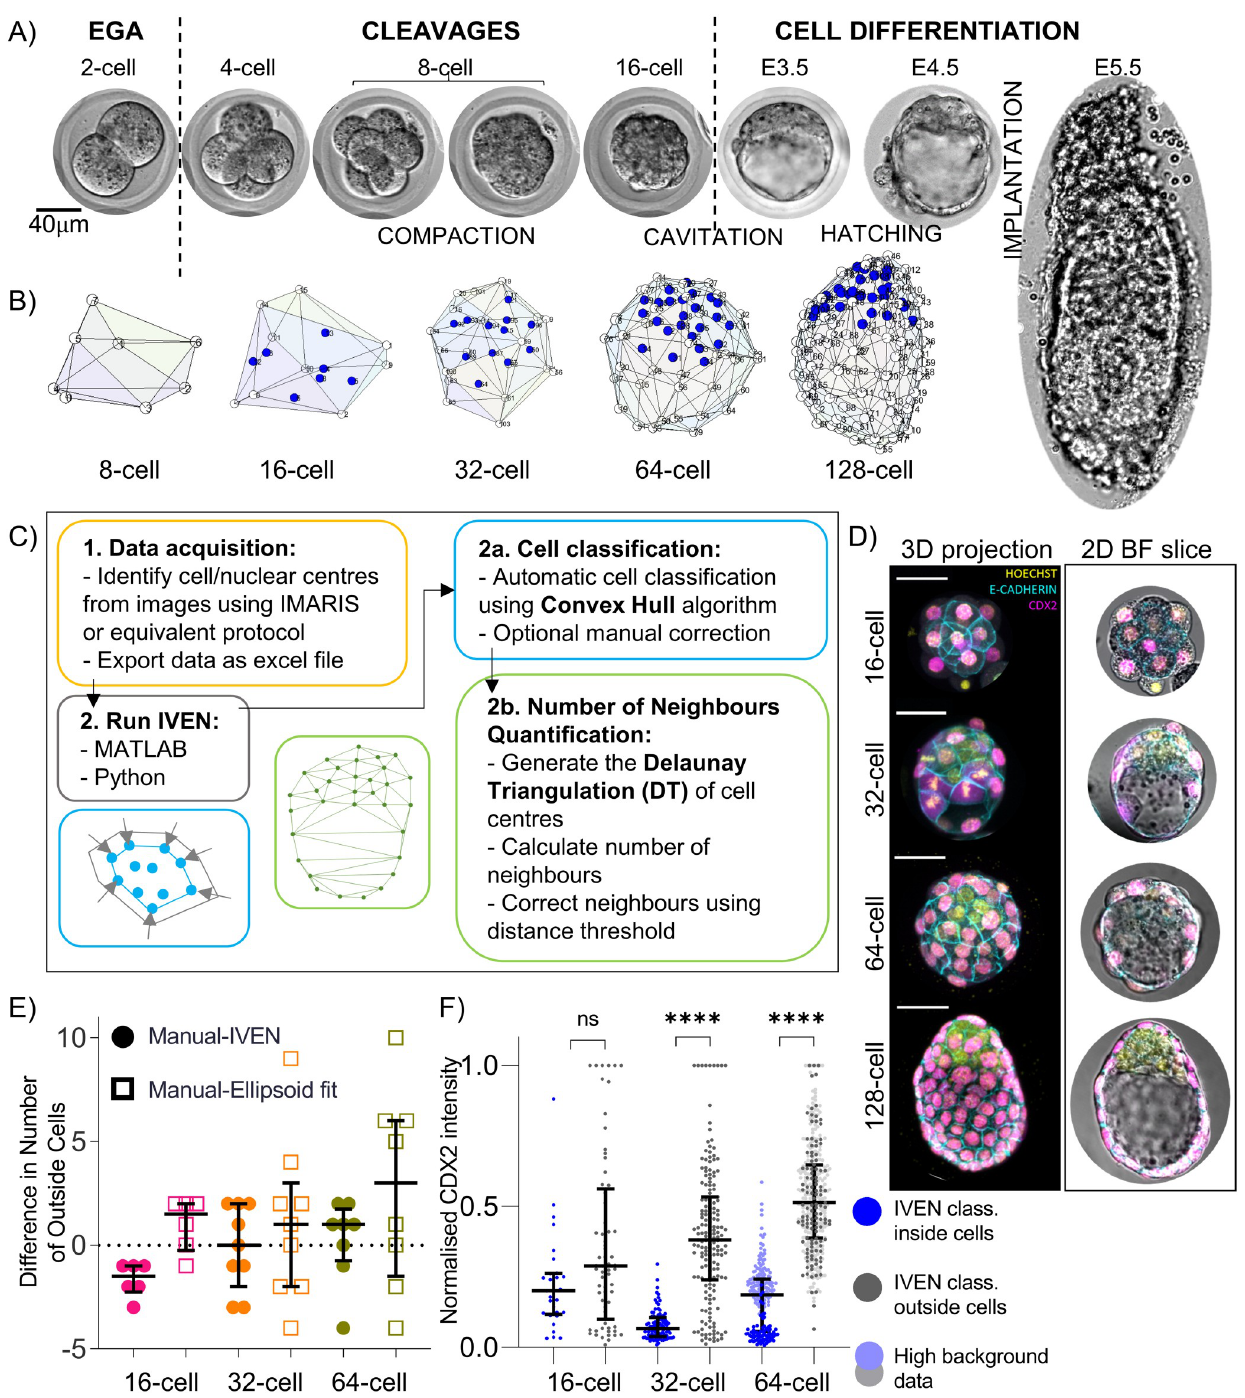
Fig 1. IVEN development and implementation in preimplantation stages of the murine embryo. (A) Brightfield images of the preimplantation and peri- implantation periods of the murine embryo. Scale bar, 40 μ m. (B) Embryo reconstructions of murine embryos at the 8-, 16-, 32-, 64-, and 128-cell stages generated within the IVEN pipeline. Outside cells are shown in white, and inside cells are shown in blue. Numbers labelled are cell IDs. (C) IVEN pipeline; data preparation (yellow box), selection of platform (grey box), cell classification (blue box), and neighbourhood quantification (green box). Blue inset shows an example 2D convex hull around 2D coordinates. Green inset shows an example DT of in silico 2D data points approximating a cross section through a blastocyst. (D) E-cadherin and CDX2 expression between the 16-cell stage and 128-cell stage. Restriction of CDX2 to outside (TE) cells by the 32-cell stage. Scale bar, 40 μ m. (E) Difference between number of outside cells as classified using IVEN (convex hull and manual reclassification where necessary, circles), ellipsoid fitting (squares), and manual identification of outside cells based on CDX2 expression and positional information per